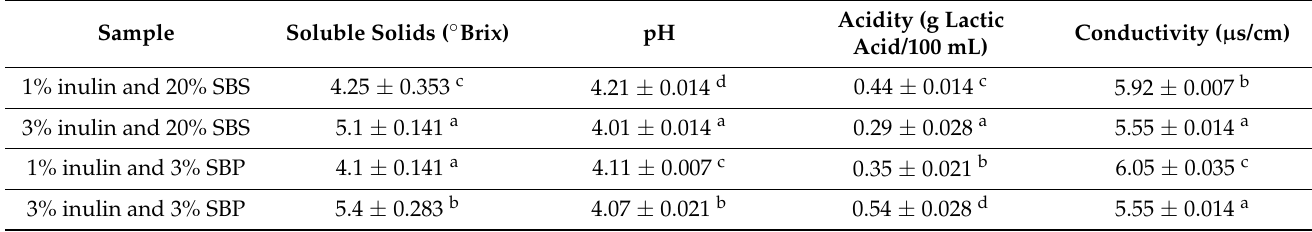
Table 1. Physicochemical analysis of the samples before fermentation.